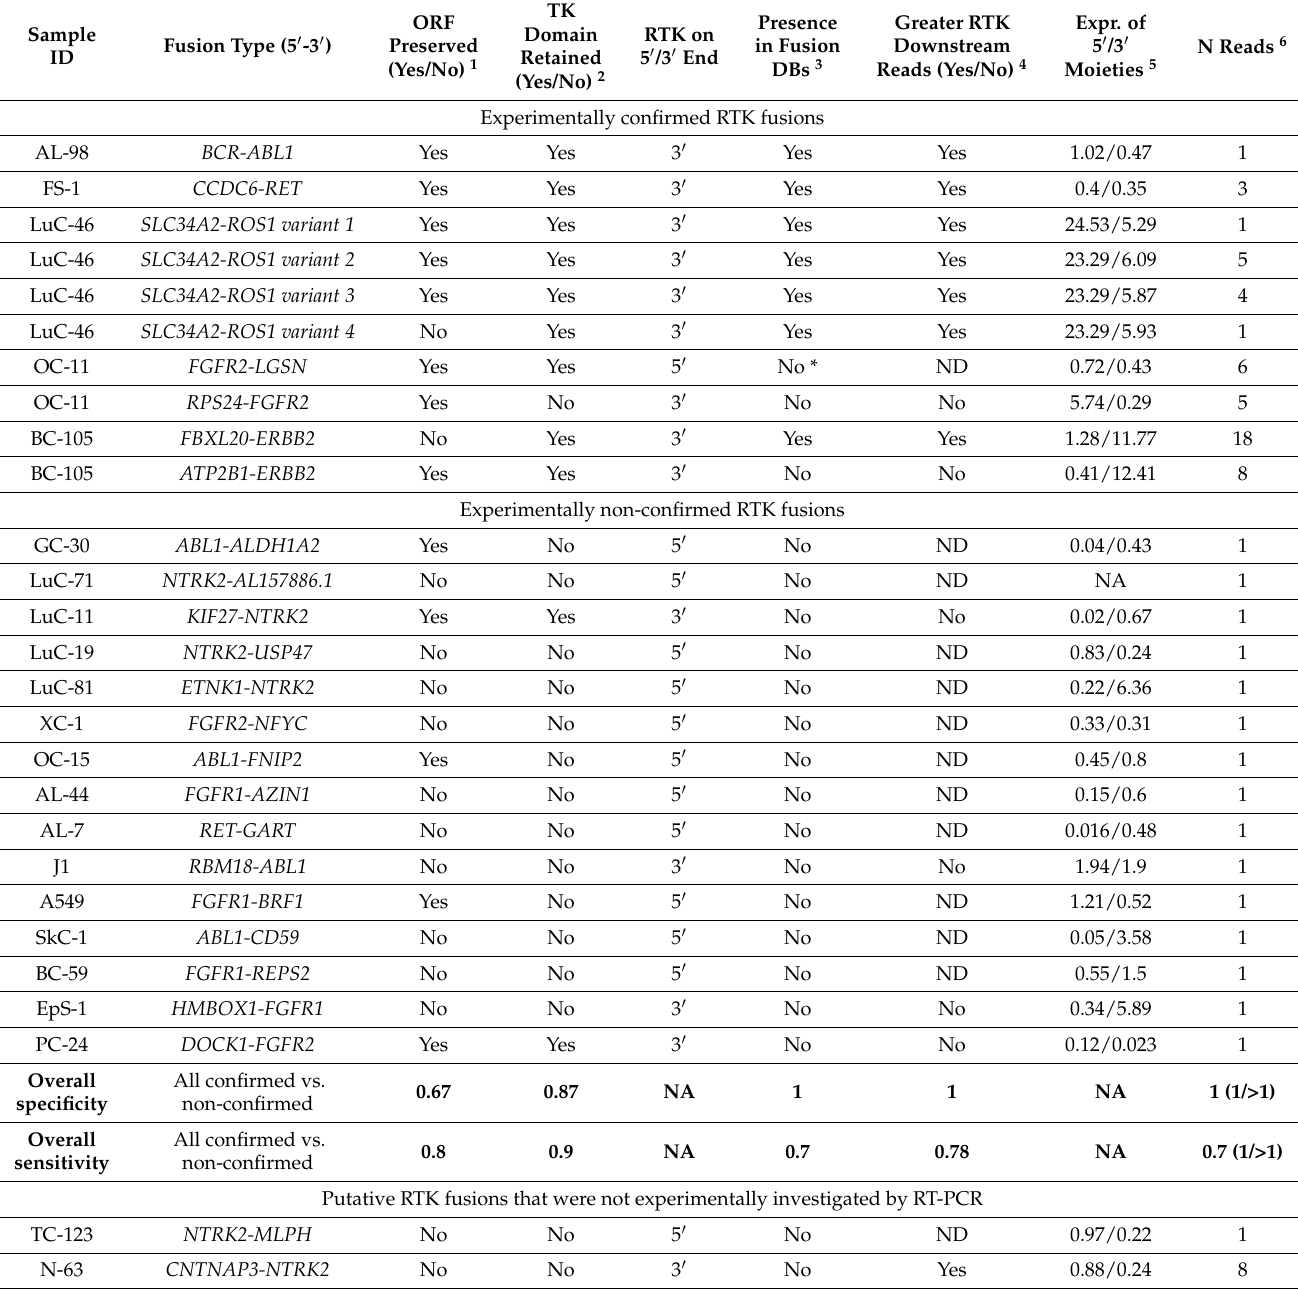
Table 1. Comparative analysis of confirmed and non-confirmed fusion structural and expression